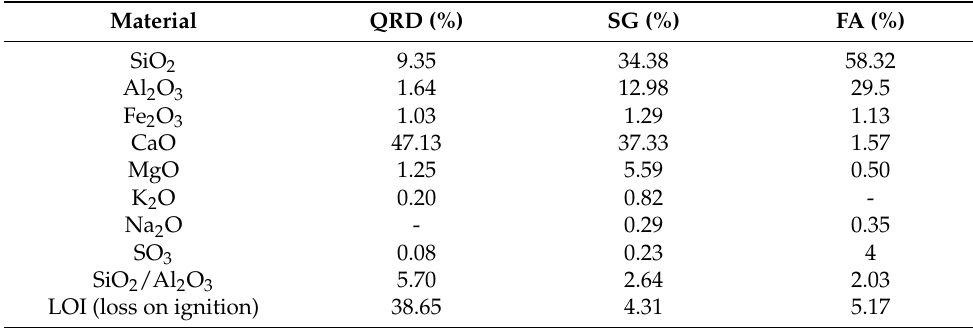
Table 1. The chemical composition of QRD, SG, and FA from XRF analysis.